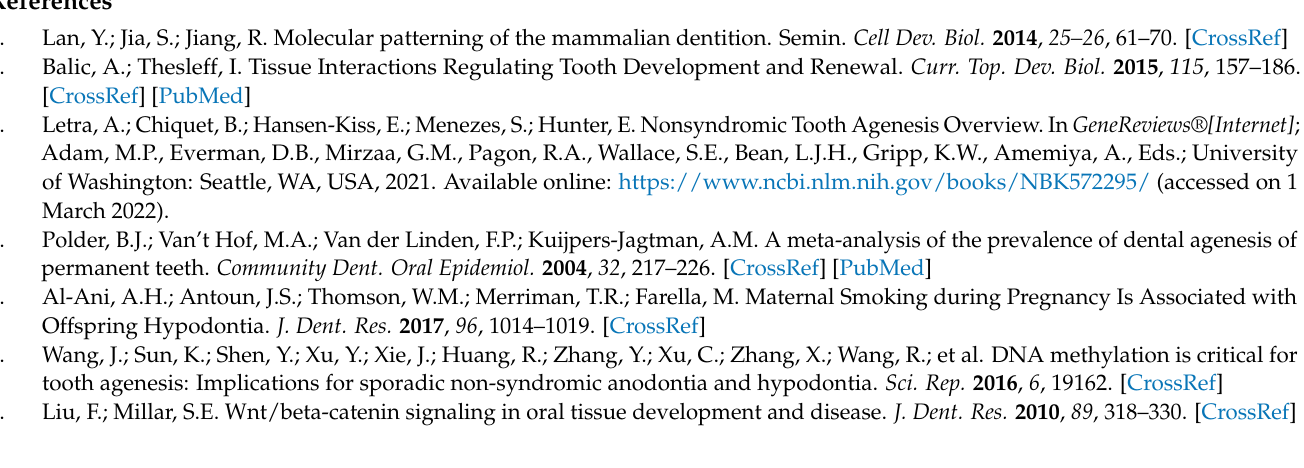
TA; Table S2: Sequencing template PCR conditions and sequencing primers; Table S3: Characteristics of genes harbouring rare variants identified in patients with ns-TA (gene-phenotype relationships); Figure S1: Detection of a novel CHD7 missense variant (p.Glu1856Gln); Figure S2: Detection of a novel CREBBP missense variant (p.Pro344Ser); Figure S3: Detection of a novel LEF1 missense variant (p.Lys95As); Figure S4: Detection of a novel ROR2 nonsense variant (p.Ser632Ter);